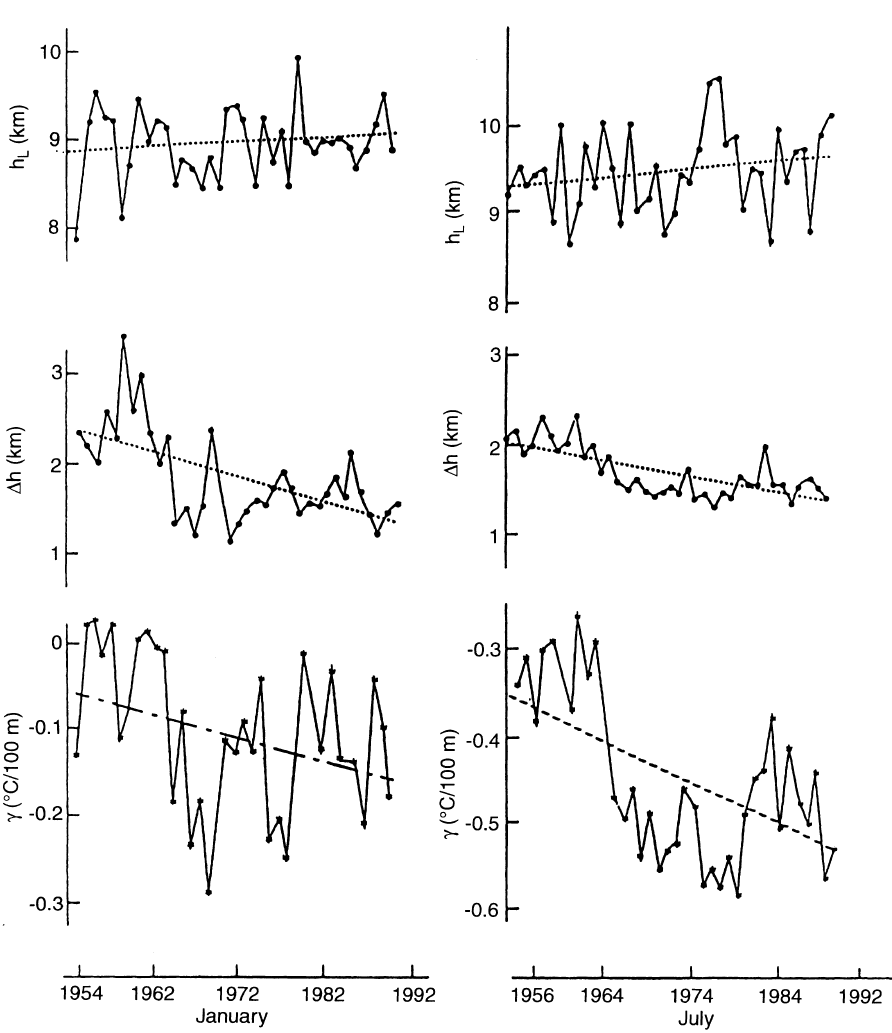
Fig. 4. Interannual variability of tropopause parameters in the Arctic during 1954–1991 (cid:133) (cid:68) h (cid:136) h H (cid:255) h L ; h H – height of upper bound; h L – height of lower bound; (cid:99) – vertical temperature gradient